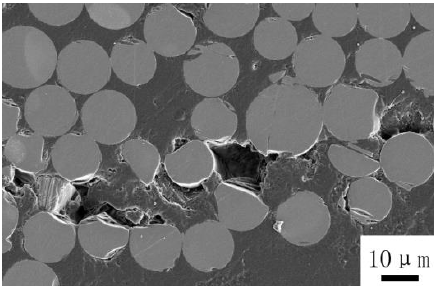
Figure 7. SEM image forthe 10° off-axis sample after thecyclic loading-unloading recovery test.